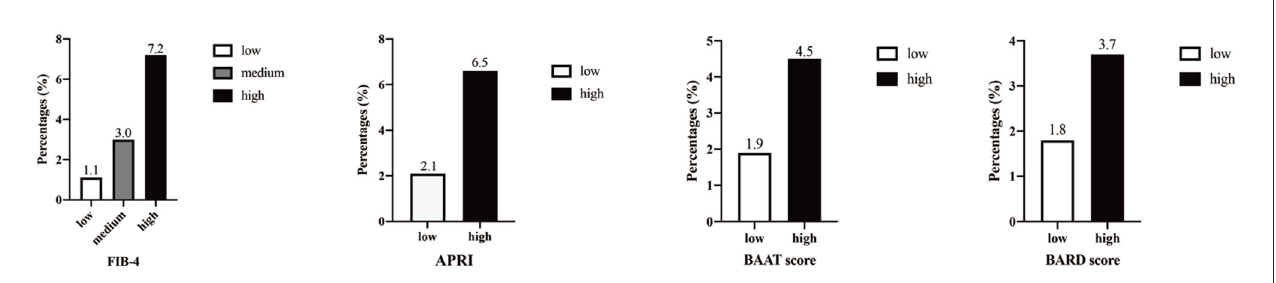
FIGURE1 The prevalence of CKD by stratification of LFSs.